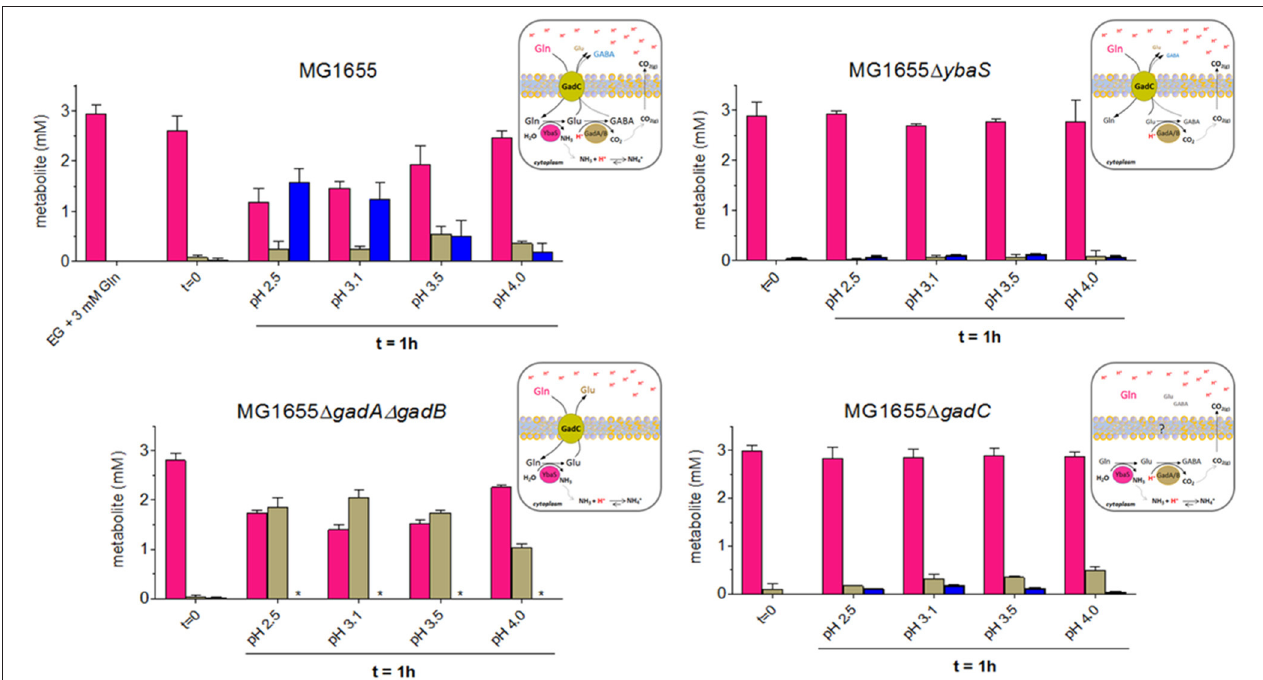
FIGURE 4 | HPLC analysis of Gln, Glu and GABA levels in EG medium at different pHs and from the different mutant strains derived from wild type E. coli MG1655. Following the protocol described in Materials and Methods (Section HPLC Analysis of Glutamine, Glutamate and GABA in Spent Media), and represented graphically in Figure S4 , bacteria were incubated for 1h at 37 ◦ C. Each spent medium was analyzed by HPLC for glutamine (magenta), glutamate (light dove) and GABA (blue) content. Each panel is accompanied by a schematic representation of the cellular context that provides a possible explanation for the observed findings. *means GABA not